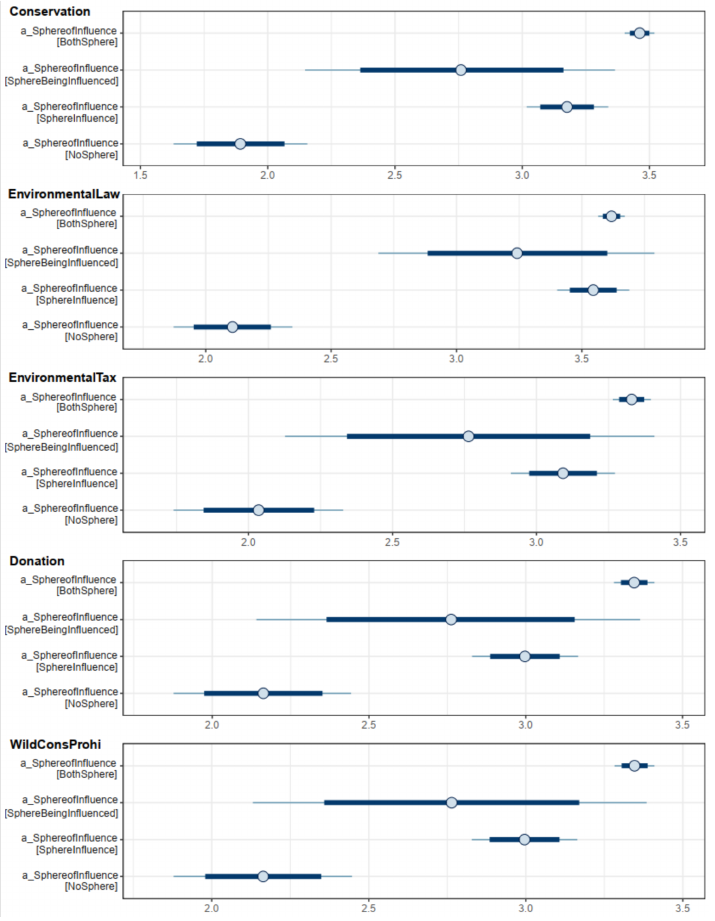
Figure 4. Posterior distributions of the